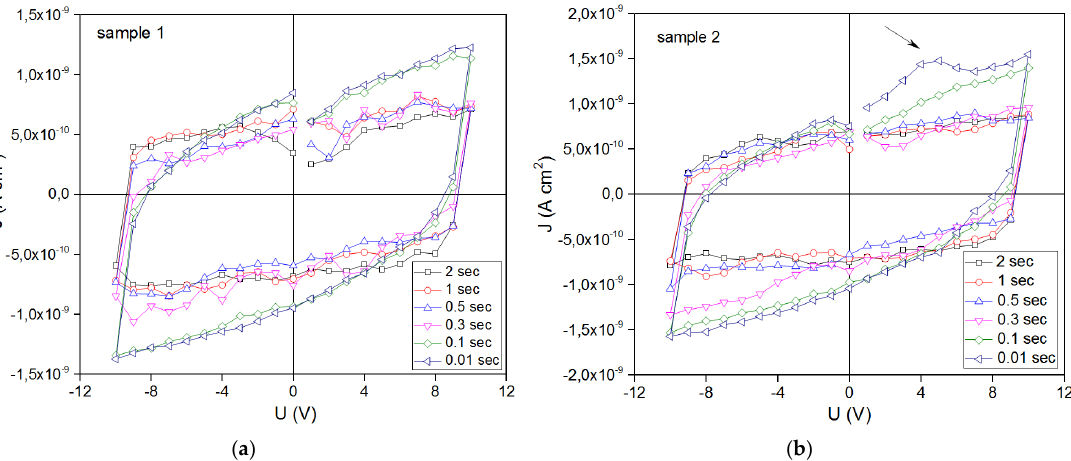
Figure 8. Current density vs applied voltage of a BFO/polyimide samples at different delay-measurement times: ( a ) sample 1, linear change; ( b ) sample 2, the appearance of a non-linear section at the time of delay measurement from t = 0.1 s.